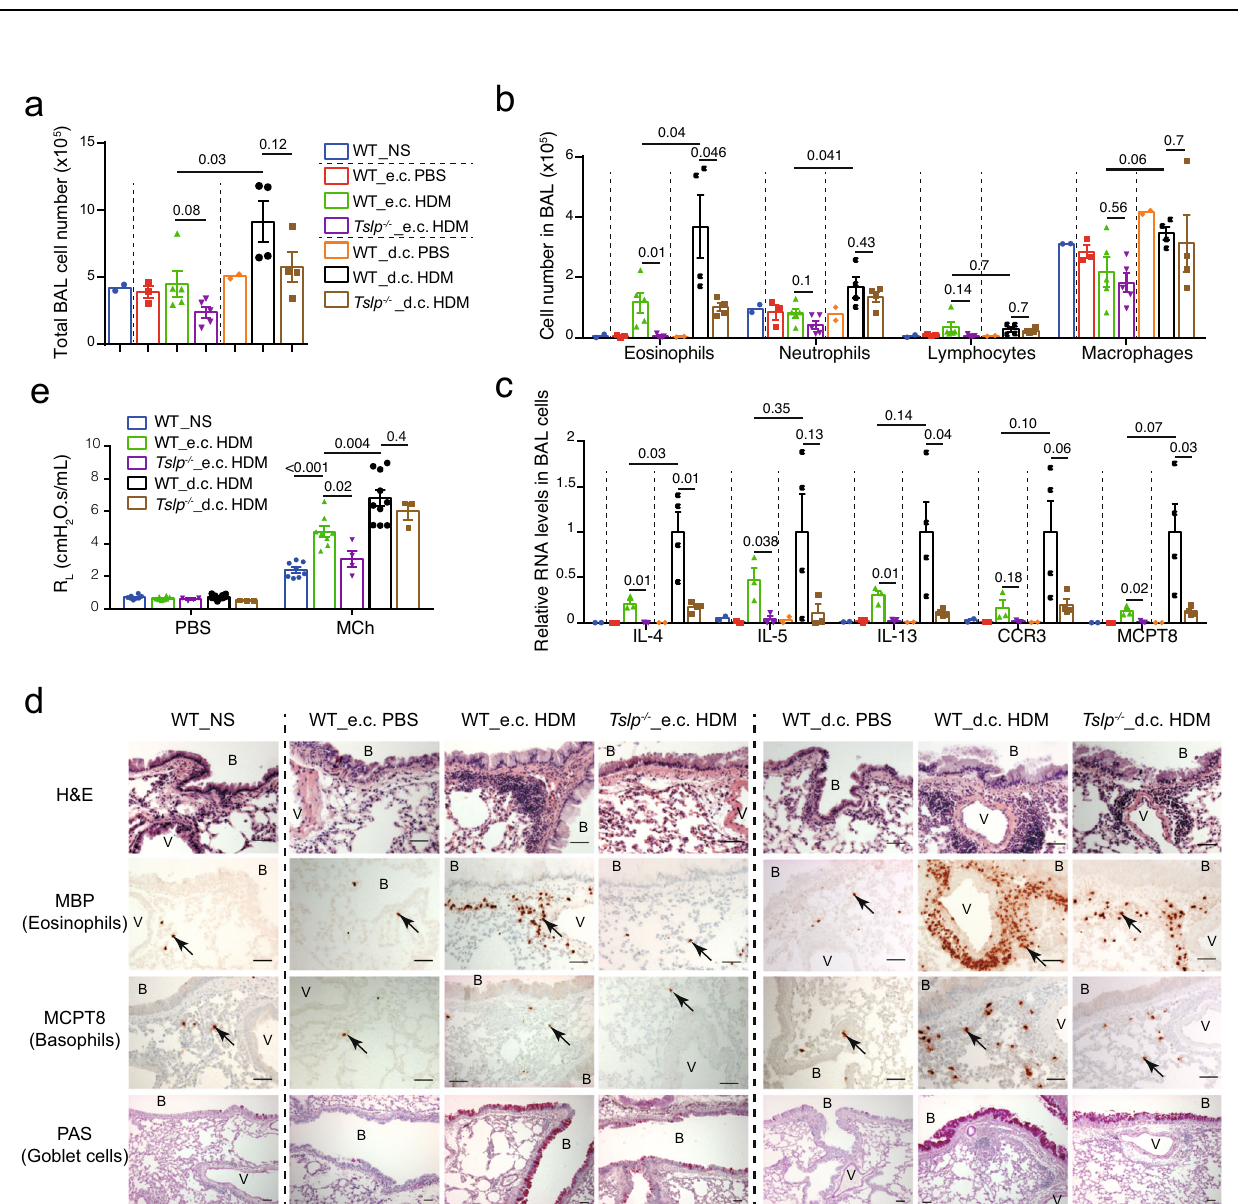
Fig. 1 | TSLP is differentially implicated for Th2/Tfh responses induced by epicutaneous or dermacutaneous HDM sensitization. a Hematoxylin & eosin (H&E) stained sections of ears collected immediately after laser microporation (LMP). Red arrow points to a micropore. NT, non-treated. b TSLP protein level in ears ( n =5, 12, 6 mice). c RNAscope in situ hybridization for TSLP mRNA. Black arrows point to one of the positive signals. Dashed lines indicate the dermal/epi- dermal junction. d Experimental protocol. House dust mites (HDM) or PBS were applied on LMP_30 μ m ears to realize e.c. sensitization, or on LMP_91 μ m ears to realized.c.sensitization,atday(D)0,3,7and10.Micewerechallengedintranasally (i.n.) with HDM every day from D9 to D12, and analysed at D13. e H&E staining,